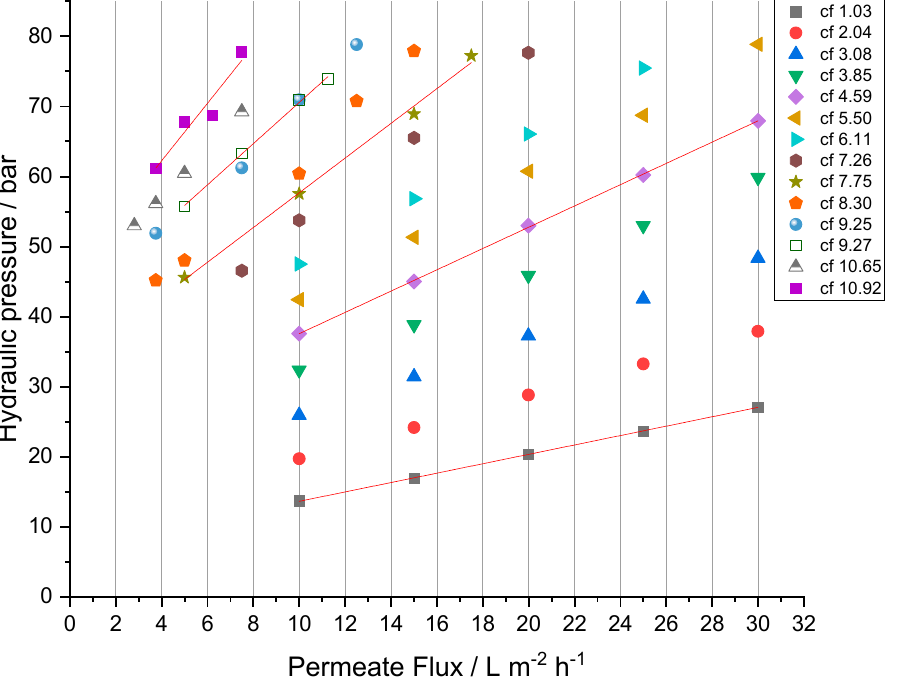
Figure 8. Correlation between hydraulic pressure and permeate flux for the different concentration factors of chromium (cf). Linear regression lines are added for visual guidance.